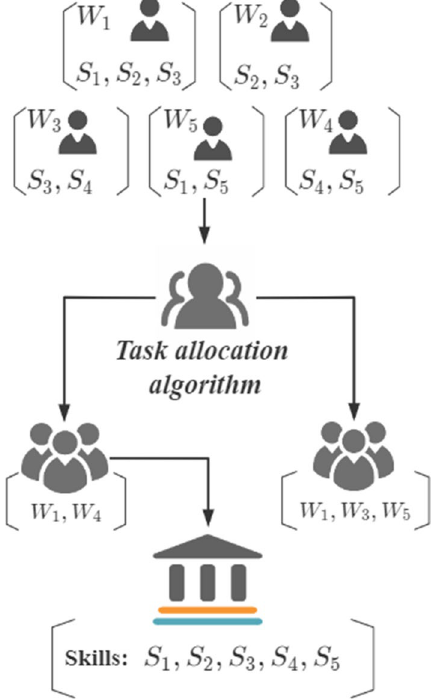
Fig. 5 Example of task